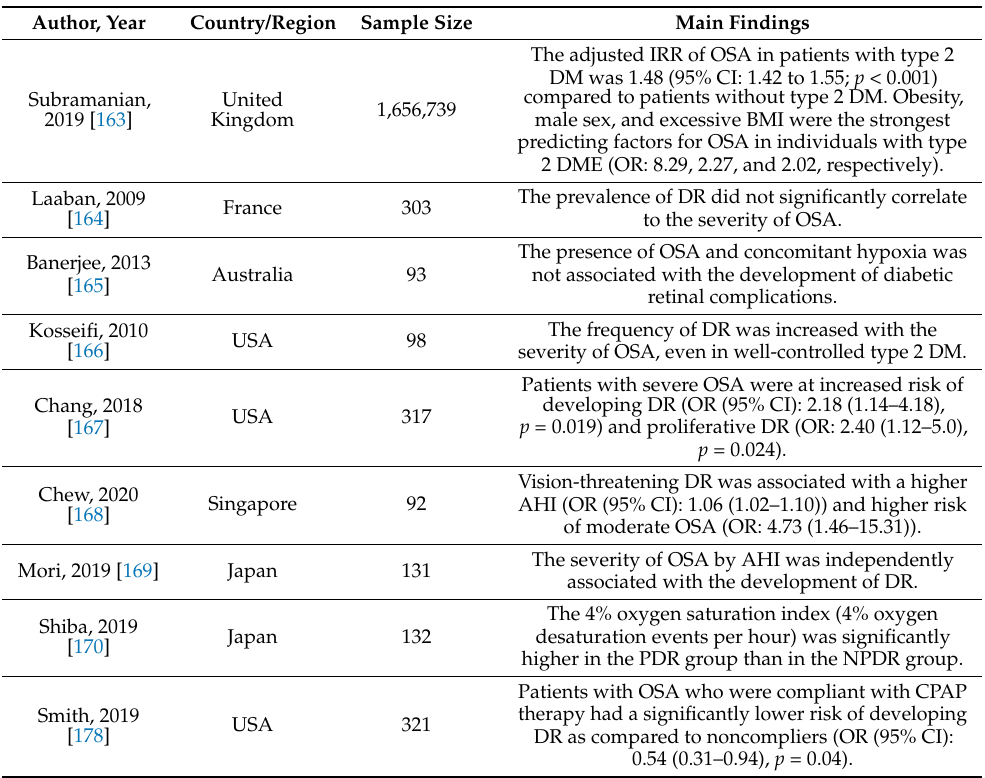
Table A6. Summary of the major studies evaluating the association between OSA and DR.